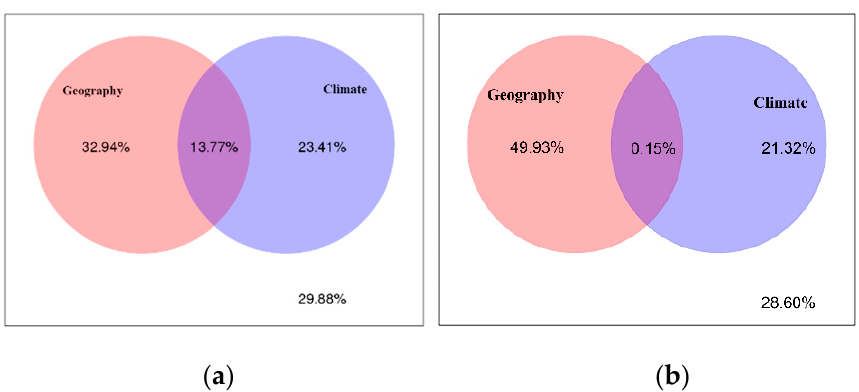
Figure 5. Variance partitioning analysis (VPA) of geographical versus climate factor on endophytic fungal ( a ) and endophytic bacterial ( b ) community composition. fungal ( a ) and endophytic bacterial ( b ) community composition.